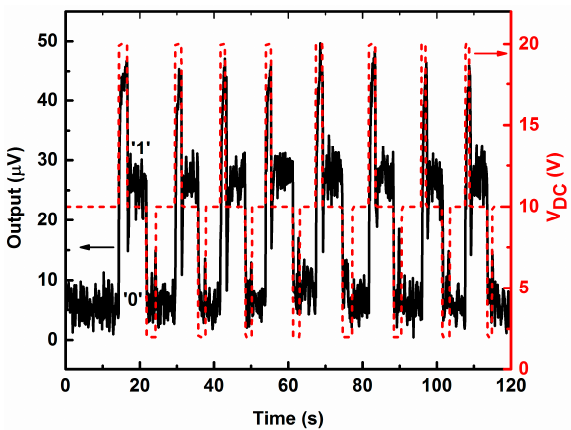
Figure 4. The sequential operation of the memory device. The black line represents the memory states (“1” or “0”). The red dashed line represents the waveform of the DC bias voltage used as write signal.